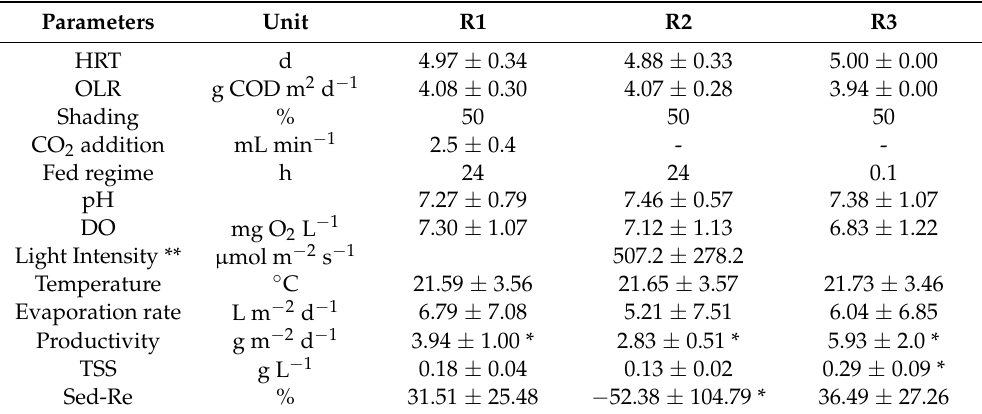
Table 2. Operational conditions, DO concentration, pH value, temperature, evaporation rate, produc- tivity, and settleability in each HRAP (R1, R2, and R3) during the experiment. Parameters Unit R1 R2 R3 HRT d 4.97 ± 0.34 OLR Shading